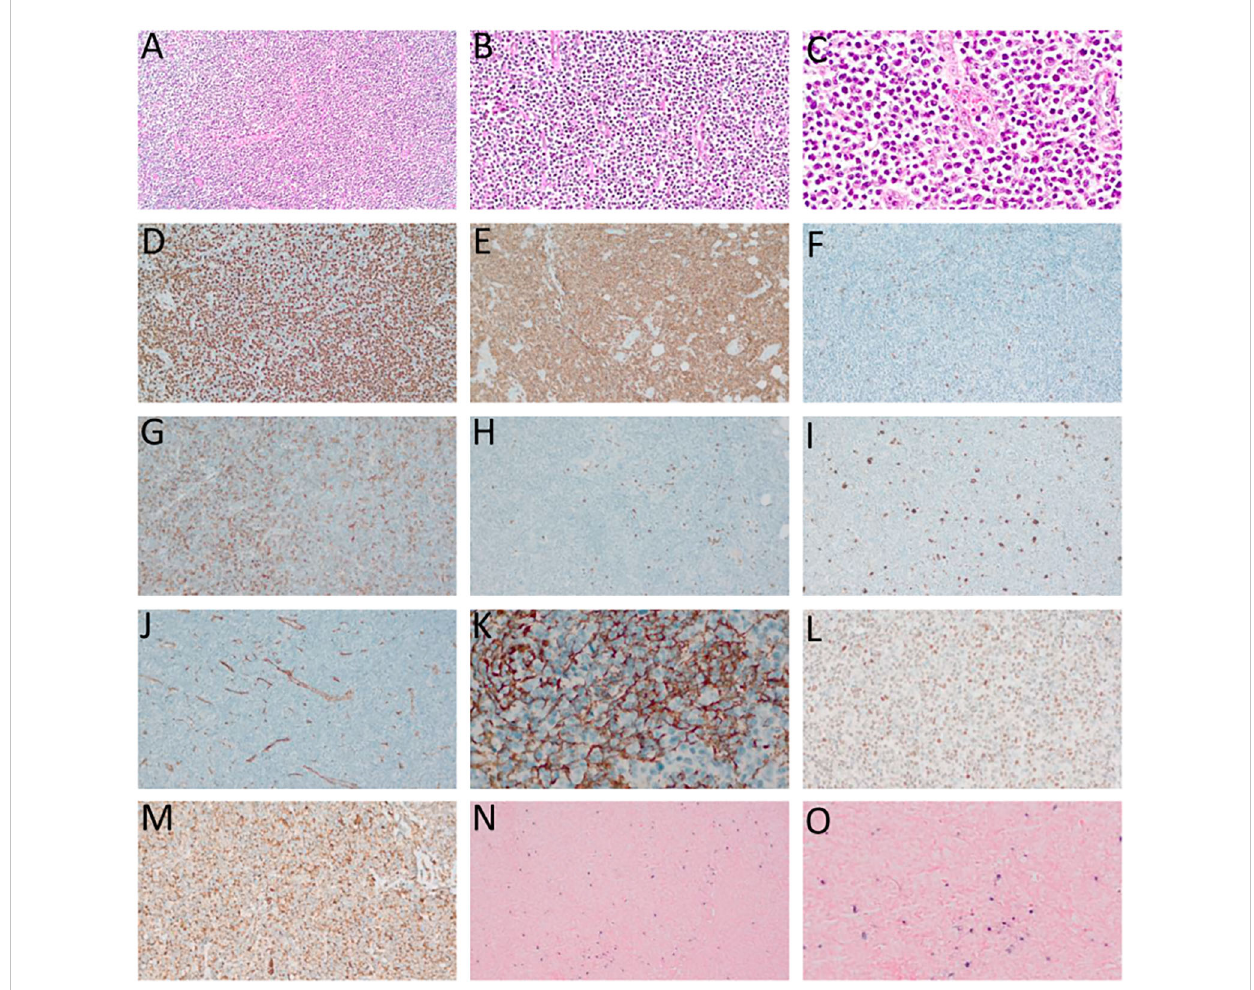
FIGURE 2 Angioimmunoblastic T-cell lymphoma (AITL). (A – C) – Hematoxylin-eosin (HE), optical microscopy, magni fi cations of 10 x (A) , 20 x (B) and 40 x (C) . Proliferation of small/medium sized atypical lymphoid cells diffusely in fi ltrating the lymph node with marked vascular proliferation. (D) high-rate of cell proliferation index - positive Ki-67 in more than 80% of the nuclei of atypical lymphoid cells. (E) Strong and diffuse labeling for the pan-T CD3 antigen. (F) Rare large CD20-positive cells in the paracortical region ( “ immunoblasts ” ). (G) CD4-positive in most neoplastic cells. (H) CD8-negative in neoplastic cells and positive in rare small reactive lymphocytes. (I) CD30-positive in large, expanded cells in the paracortical region with RS-like morphology. (J) Exuberant vascular proliferation with high endothelial venules (VEA) enhanced by CD34. (K) Expanded follicular dendritic cell (FDC) meshwork, labeling for CD21. (L) BCL6 positive and (M) CD10 positive, both markers of TFH origin. (N, O) In situ hybridization (ISH) for EBV, positivity for EBERs (Epstein-Barr small encoded-RNAs), staining in black, “ speckled ” pattern, revealing EBV staining in RS-like immunoblasts in the paracortex. (D – F, H, L – N) – Optical microscopy, 10 x magni fi cation. (I, J, O) – Optical microscopy, 20 x magni fi cation; (K) – Optical microscopy, 40 x magni fi